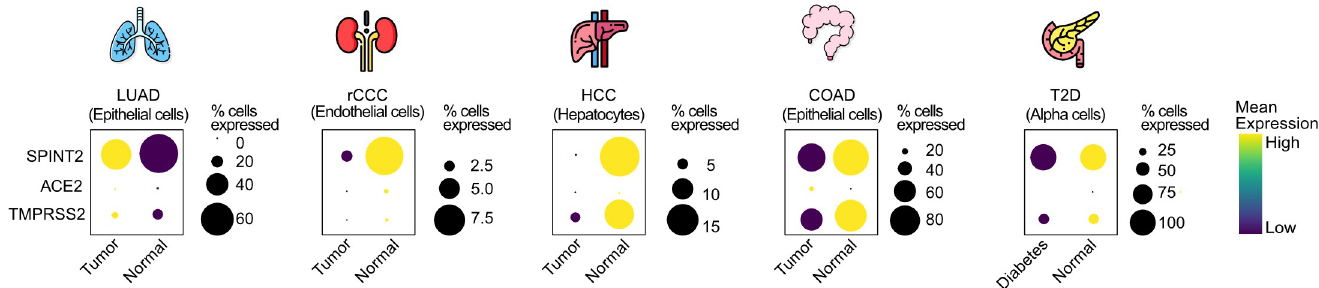
Fig 7. SPINT2 is down-regulated in tumors and diabetic pancreatic cells. Dot plots showing gene expression and percentage of cells expressing SPINT2 , ACE2 and TMPRSS2 in tumors and pancreatic alpha cells. The selected cell type for each tumor type is indicated in each case. Lung Adenocarcinoma (LUAD), renal Clear Cell Carcinoma (rCCC), Hepatocyte Cell Carcinoma (HCC), Colon Adenocarcinoma (COAD), Type 2 diabetes (T2D).